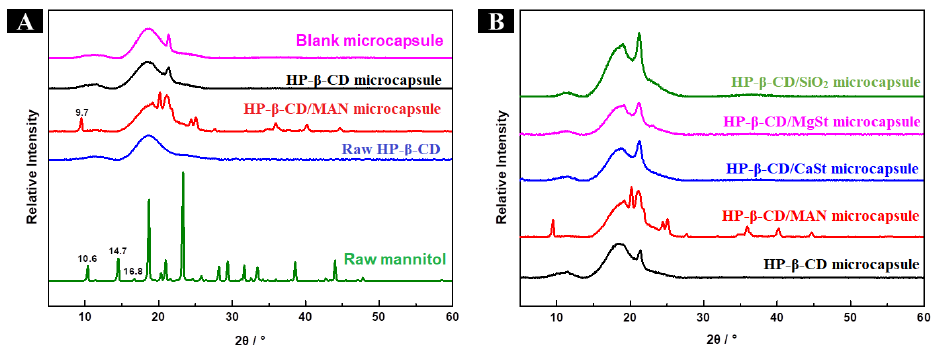
Figure 2. XRD patterns of ( A ) raw materials (HP- β -CD and mannitol), HP- β -CD microcapsules, HP- β -CD/MAN microcapsules, blank microcapsules (without essence) and ( B ) microcapsules with different anticaking agents.